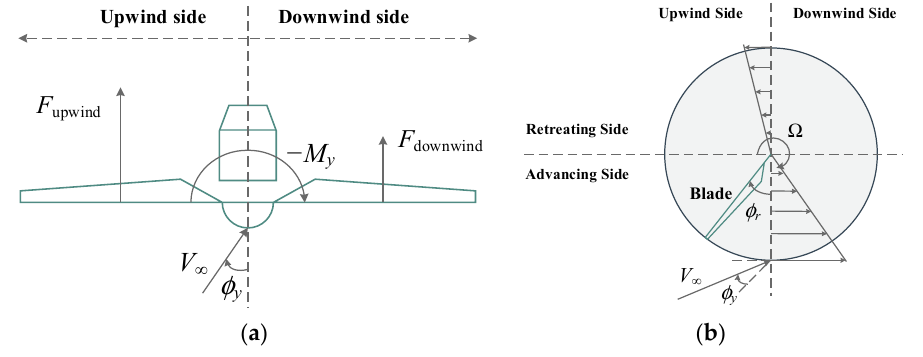
Figure 5. Schematic of a wind turbine in the yawed condition. ( a ) Top view; ( b ) Front view. Appl. Sci. 2018 , 8 , x FOR PEER REVIEW